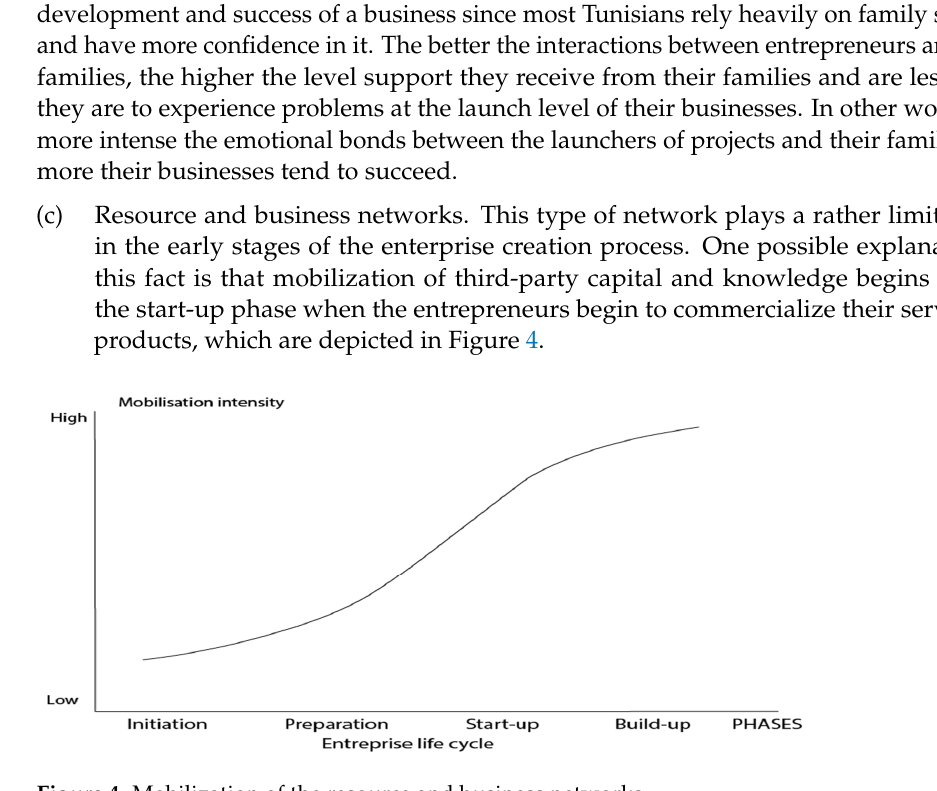
Figure 4. Mobilization of the resource and business networks.